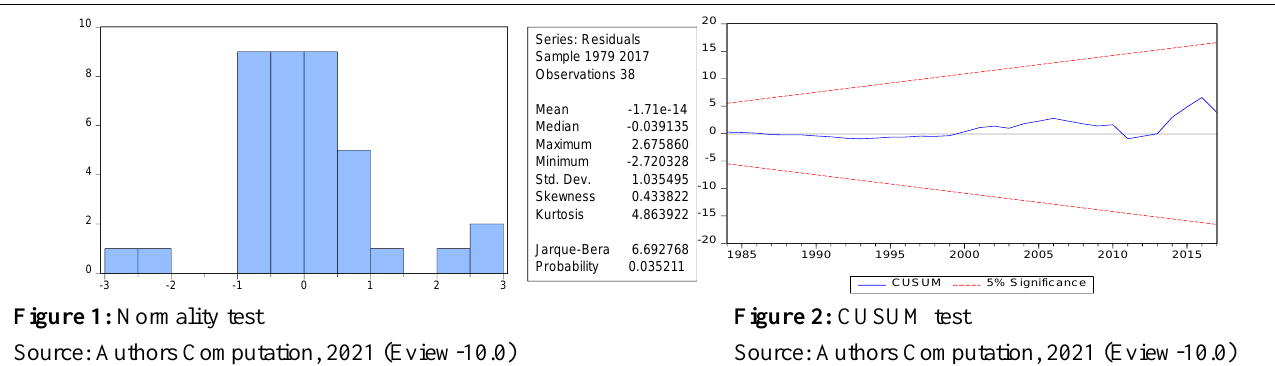
Figure 1: Normality test Figure 2: CUSUM